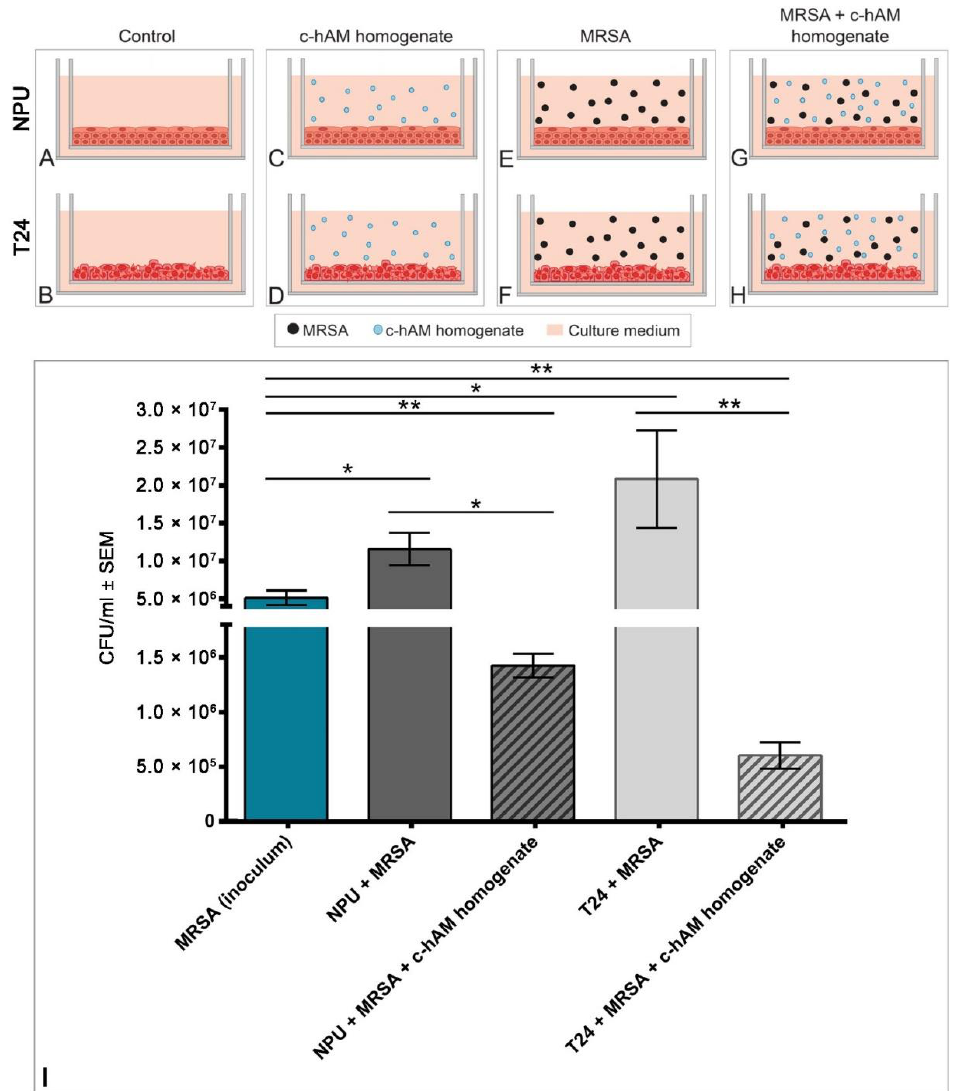
Figure 5. The effect of c-hAM homogenate on MRSA-infected biomimetic in vitro models of the normal and cancerous urothelium. ( A – H ) Scheme of the experiment. The normal porcine urothelial (NPU) and T24 cells were incubated for 3 h in the ( A , B ) culture medium (control), ( C , D ) c-hAM homogenate, ( E , F ) culture medium inoculated with MRSA, ( G , H ) c-hAM homogenate inoculated with MRSA. ( I ) The number of bacteria in MRSA-infected samples, incubated in the presence or absence of c-hAM homogenate. The c-hAM homogenate significantly decreased the number of bacteria in biomimetic in vitro models of the normal and cancerous urothelium. * p < 0.05; ** p < 0.001.